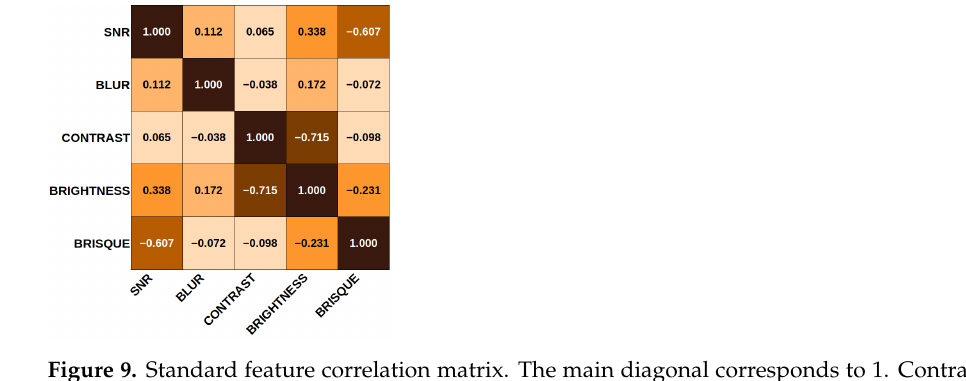
Figure 9. Standard feature correlation matrix. The main diagonal corresponds to 1. Contrast and brightness are inversely related in proportion. The minor related features contrast vs. blur and contrast vs. SNR. There is an inverse relationship between SNR and BRISQUE.